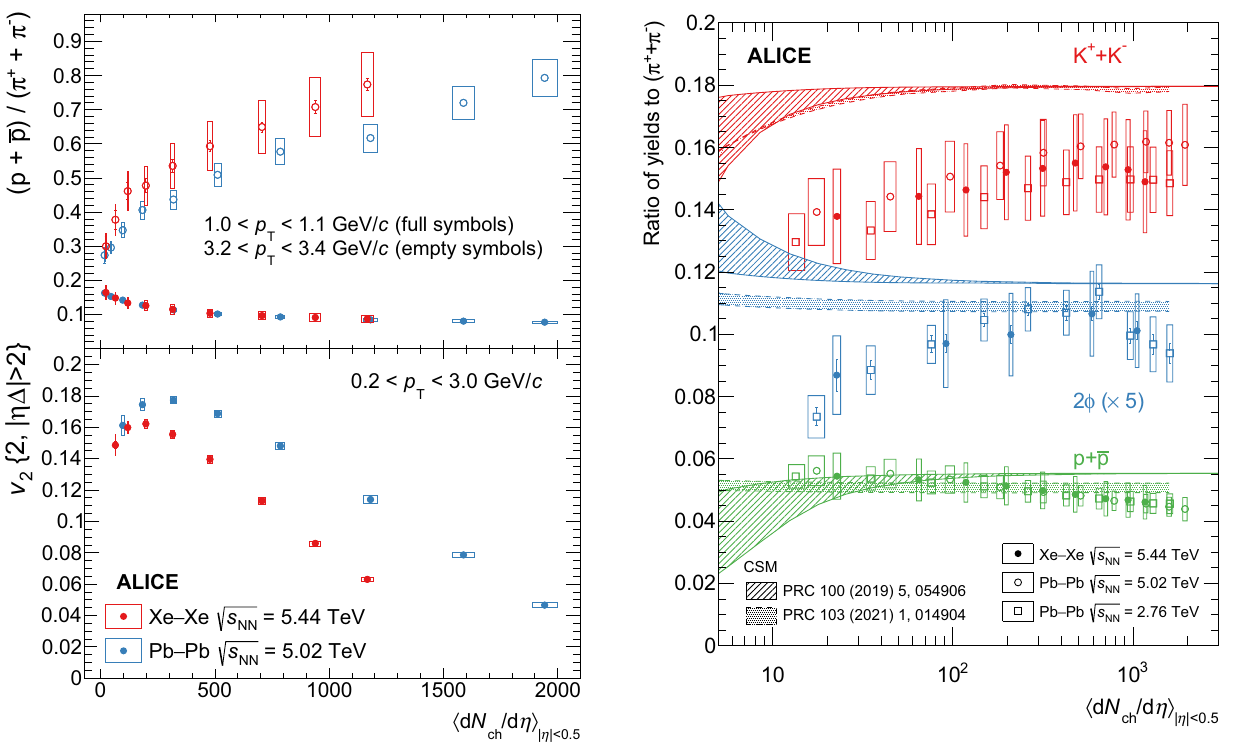
Fig. 5 Proton-to-pion ratio as a function of charged particle multi- plicity density in two p T intervals for Xe–Xe and Pb–Pb collisions at √ s NN = 5.44 and 5.02 TeV. In the bottom panel, the flow coefficient v { 2 , | (cid:14)η | > 2 } is plotted for the same collision systems [24,55] as 2 a function of charged particle multiplicity density. The statistical and systematic uncertainties are shown as error bars and boxes around the data points